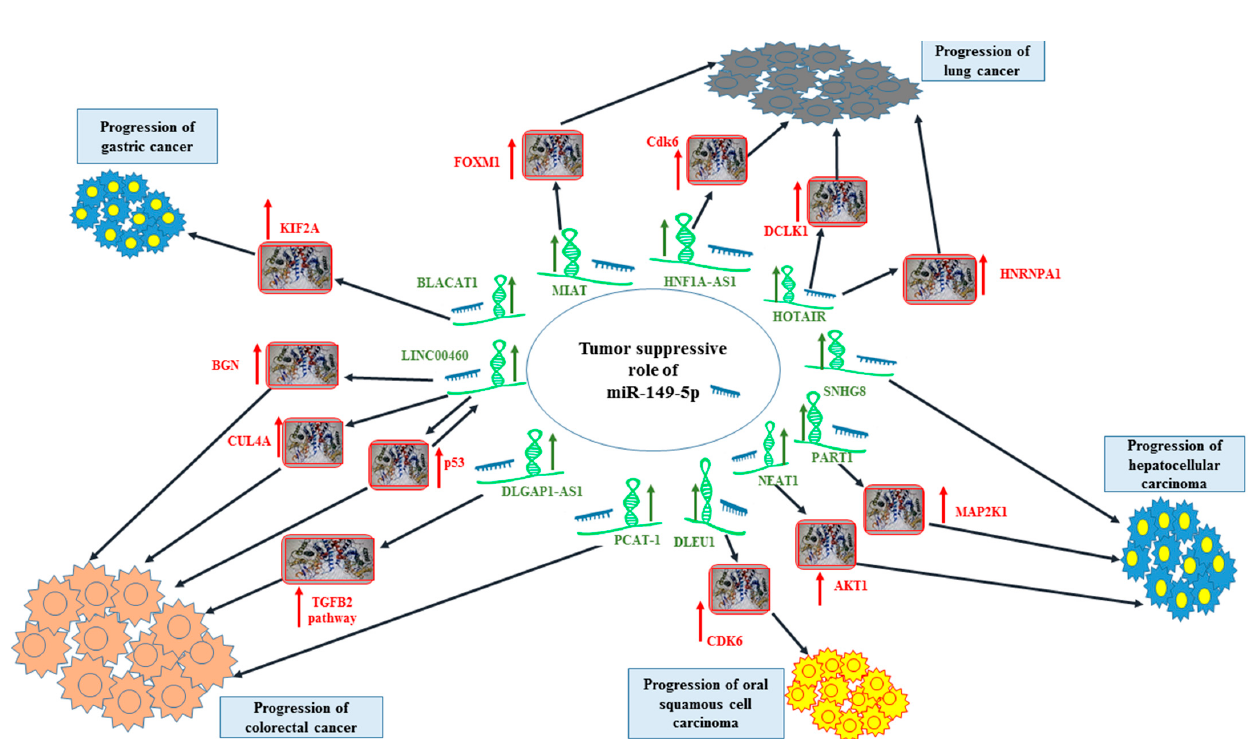
Figure 2. Tumor-suppressive role of miR-149-5p in gastric cancer, lung cancer, colorectal cancer, hepatocellular carcinoma and oral squamous cell carcinoma.